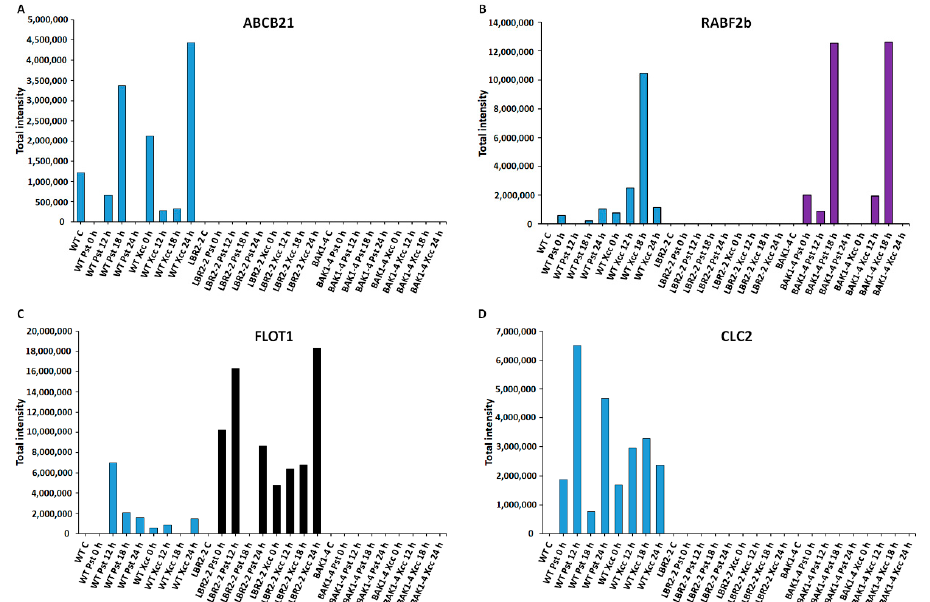
Figure 4. Comparative analyses of total peak intensities of PM-associated proteins involved in membrane transport and trafficking . Total peak intensity of selected significant PM-associated proteins for ( A ) ABC transporter B family member 21 (ABCB21), ( B ) Ras-related protein (RABF2b), ( C ) Flotillin-like protein 1 (FLOT1) and ( D ) Clathrin light chain 2 (CLC2). Data from the WT are indicated in blue, the lbr2-2 mutant in black and the bak1-4 mutant in purple, with time periods of 0–24 h as indicated.